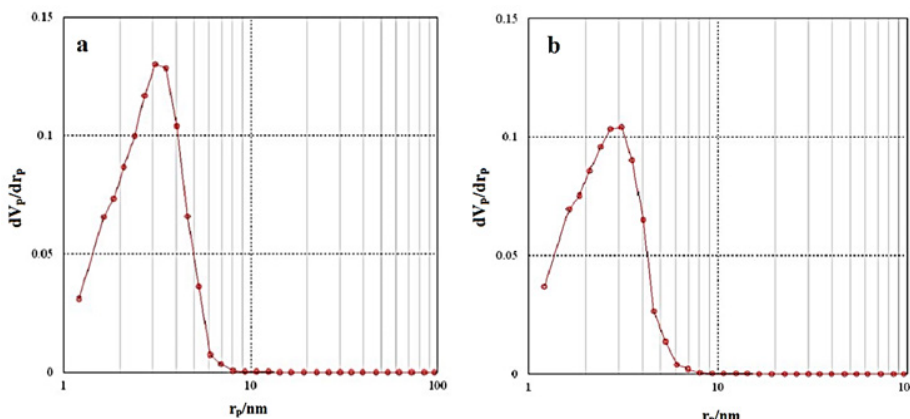
Fig. 5. BJH pore size distribution, a) Al-B catalyst, b) Al-A